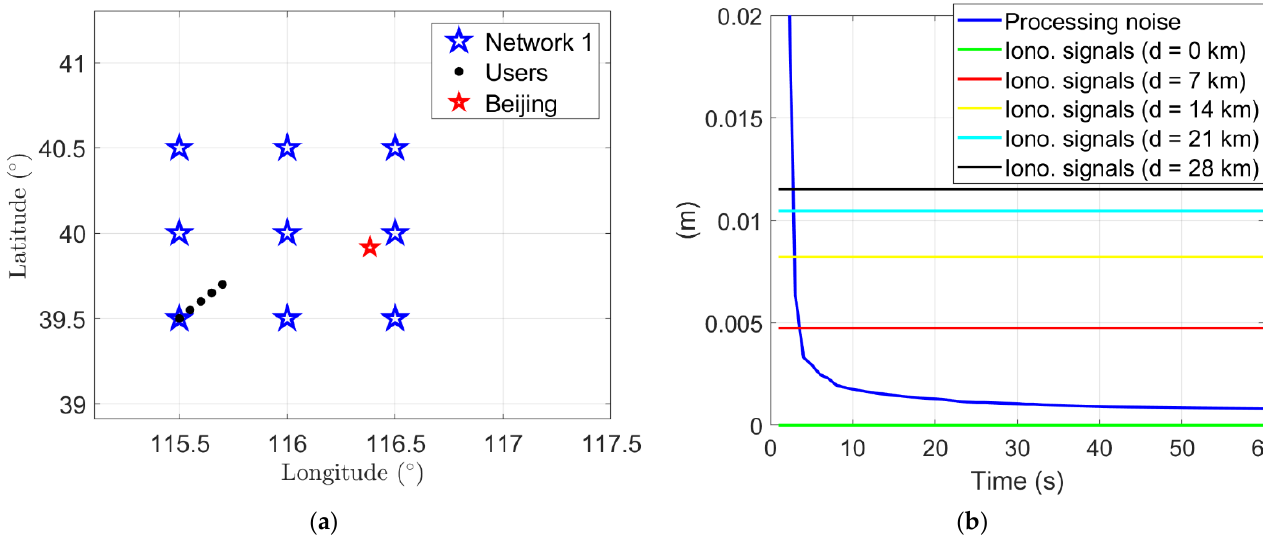
Figure 4. ( a ) Locations of the tested users in Network 1 and ( b ) formal standard deviations of the between-satellite network corrections for C26 and C29 on L1 phase induced by the processing noise (blue) and the ionospheric signals (other color lines). σ ι